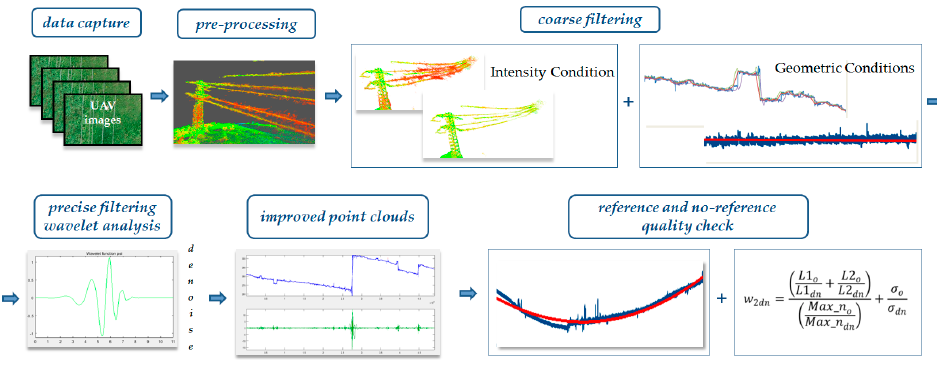
Figure 3. Block diagram of the overall method.